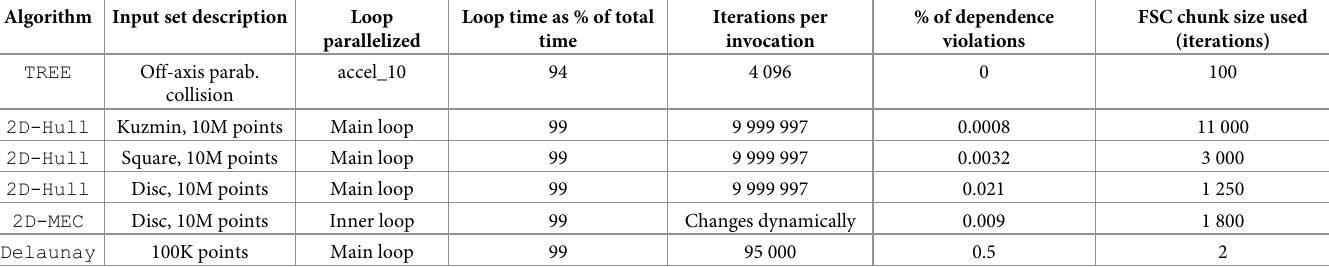
Table 2. Characteristics of the algorithms and input sizes